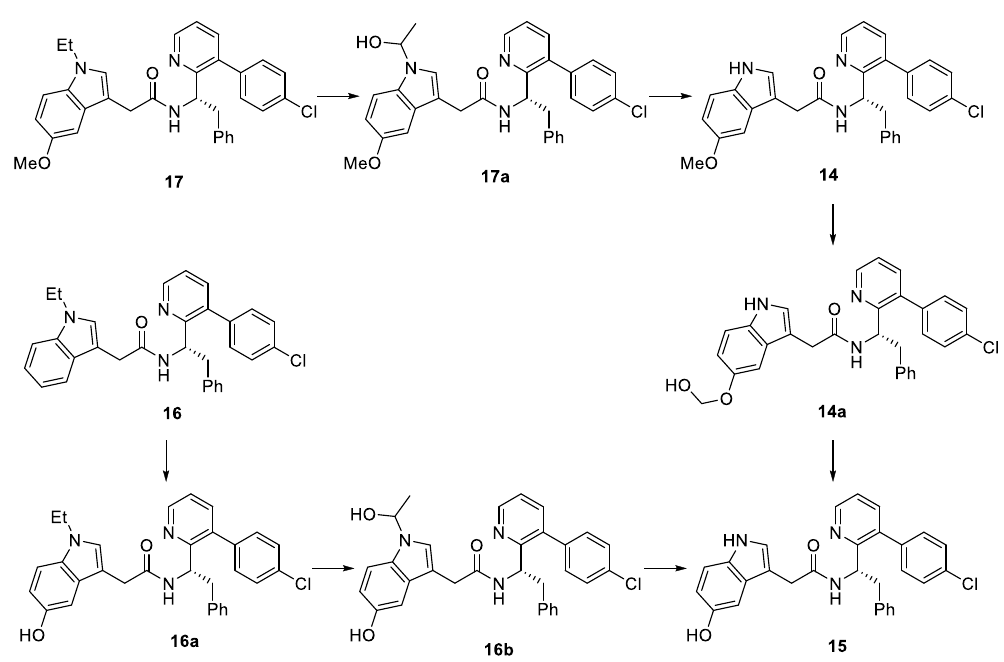
Figure 5. Proposed metabolic pathways of 17 , 14 and 16 toward 15 . Major cyclophilin- (CYP)-mediated oxidative reactions include oxidative O-de-methylation and N-de-ethylation, and 5′-hydroxylation of the indole ring.